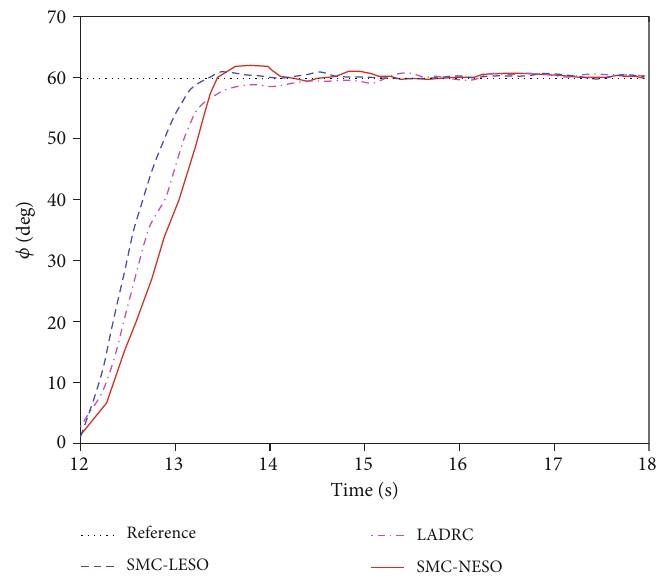
Figure 13: Results from roll angle tracking control when wind gusts exist.